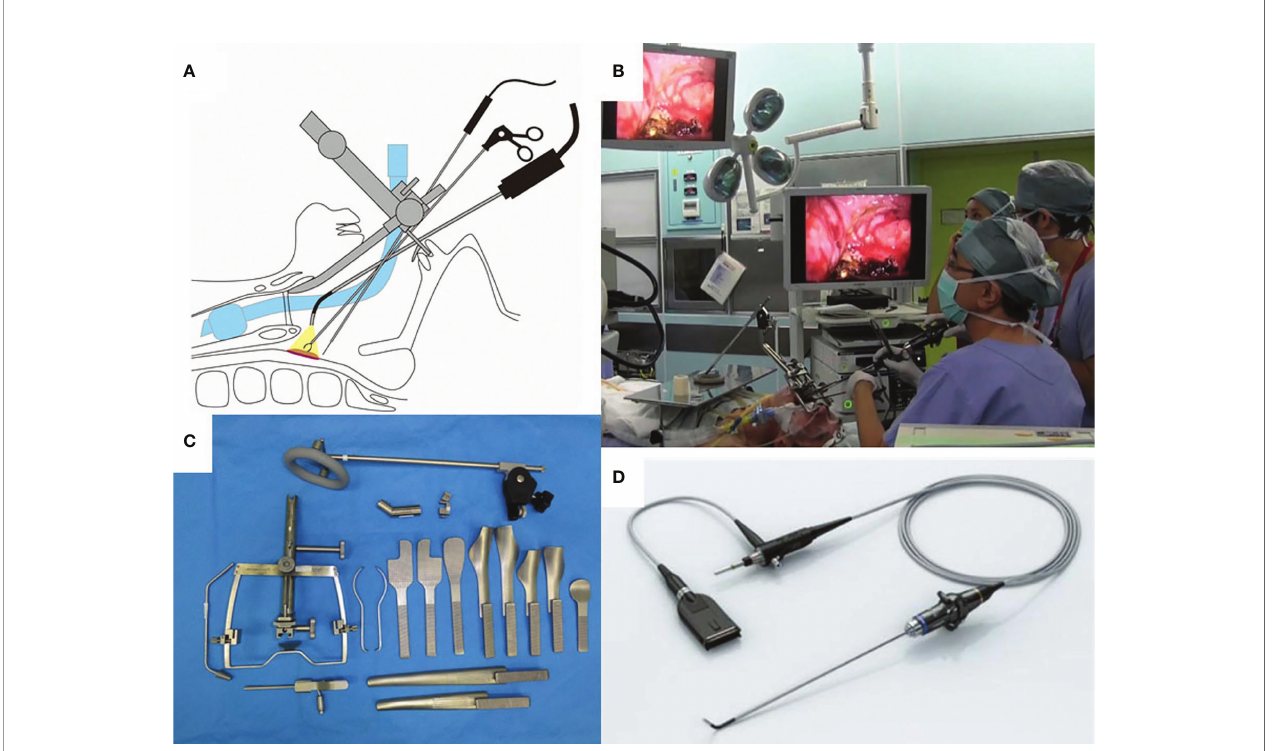
FIGURE 1 | (A) Shema of transoral videolaryngoscopic surgery (TOVS). (B) Surgical setup of TOVS. (C) FK-WO retractor (Olympus Medical Systems, Tokyo Japan). (D) Endoeye Flex (Olympus). Used with permission from